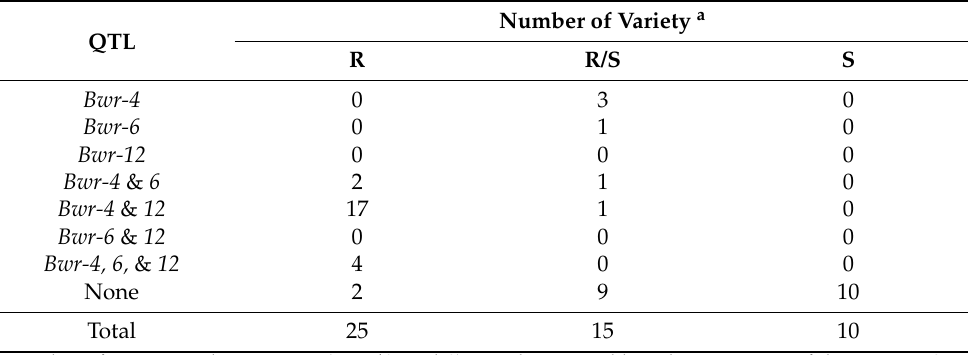
Table 4. Summary of genotyping for three major QTL associated with bacterial wilt resistance in 50 tomato